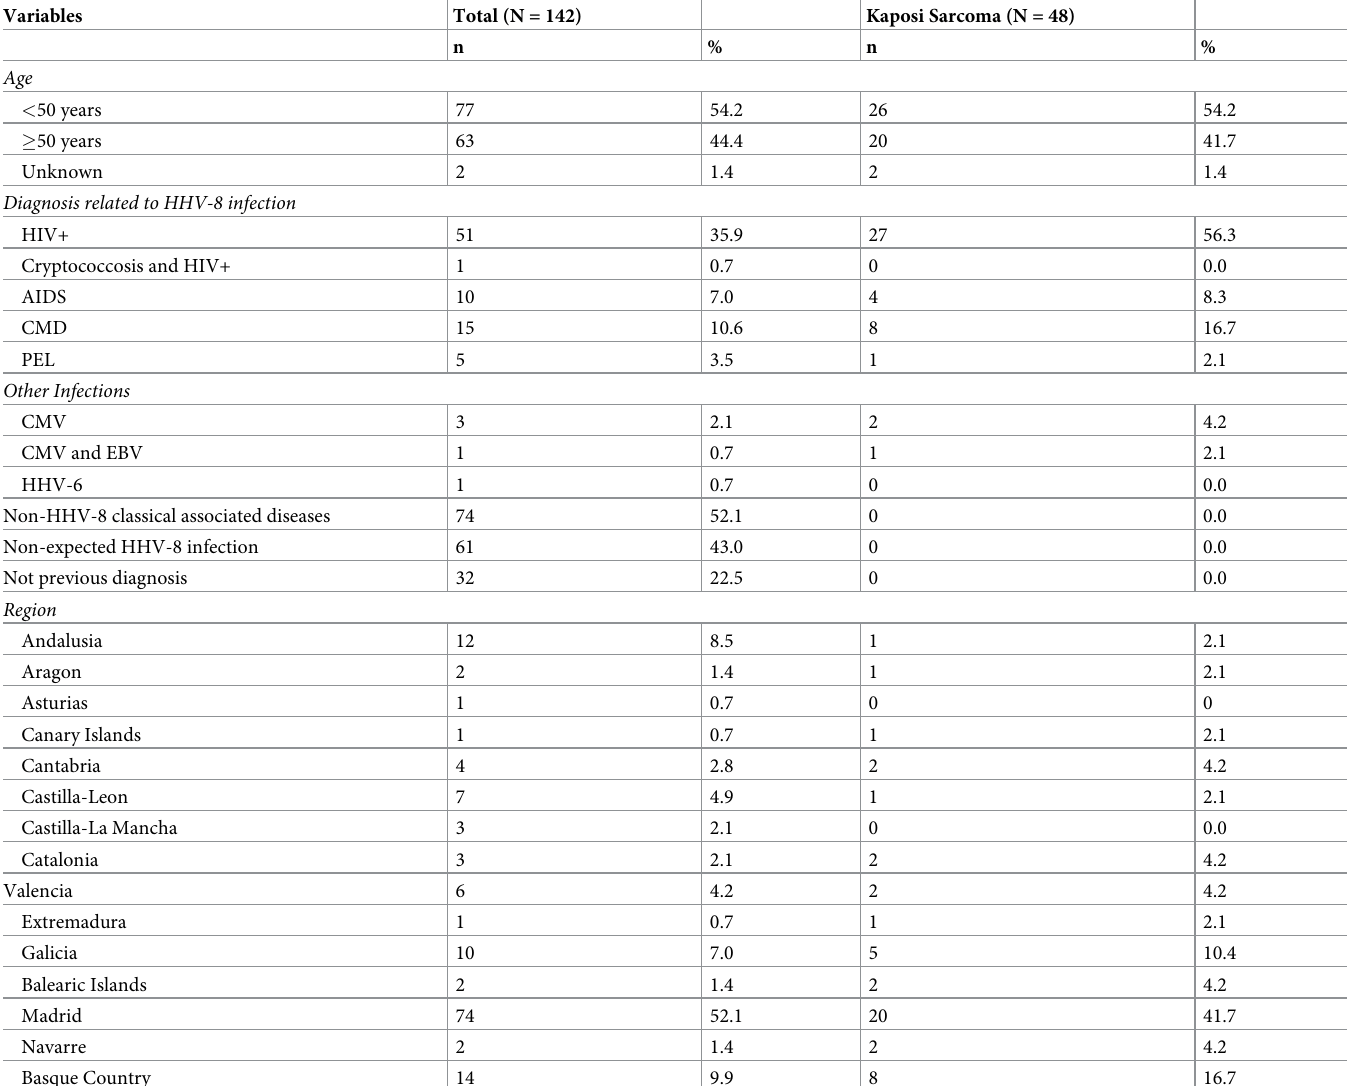
Table 2. Baseline characteristics of the 142 patients included in the